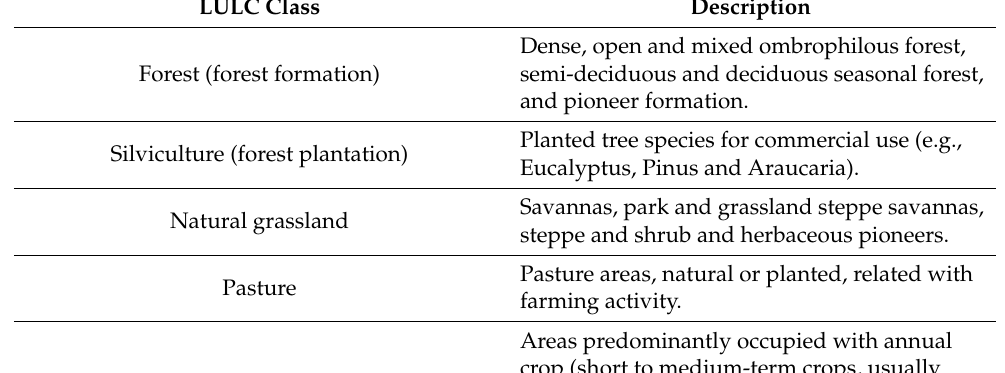
Table 2. Land use and land cover description. LULC